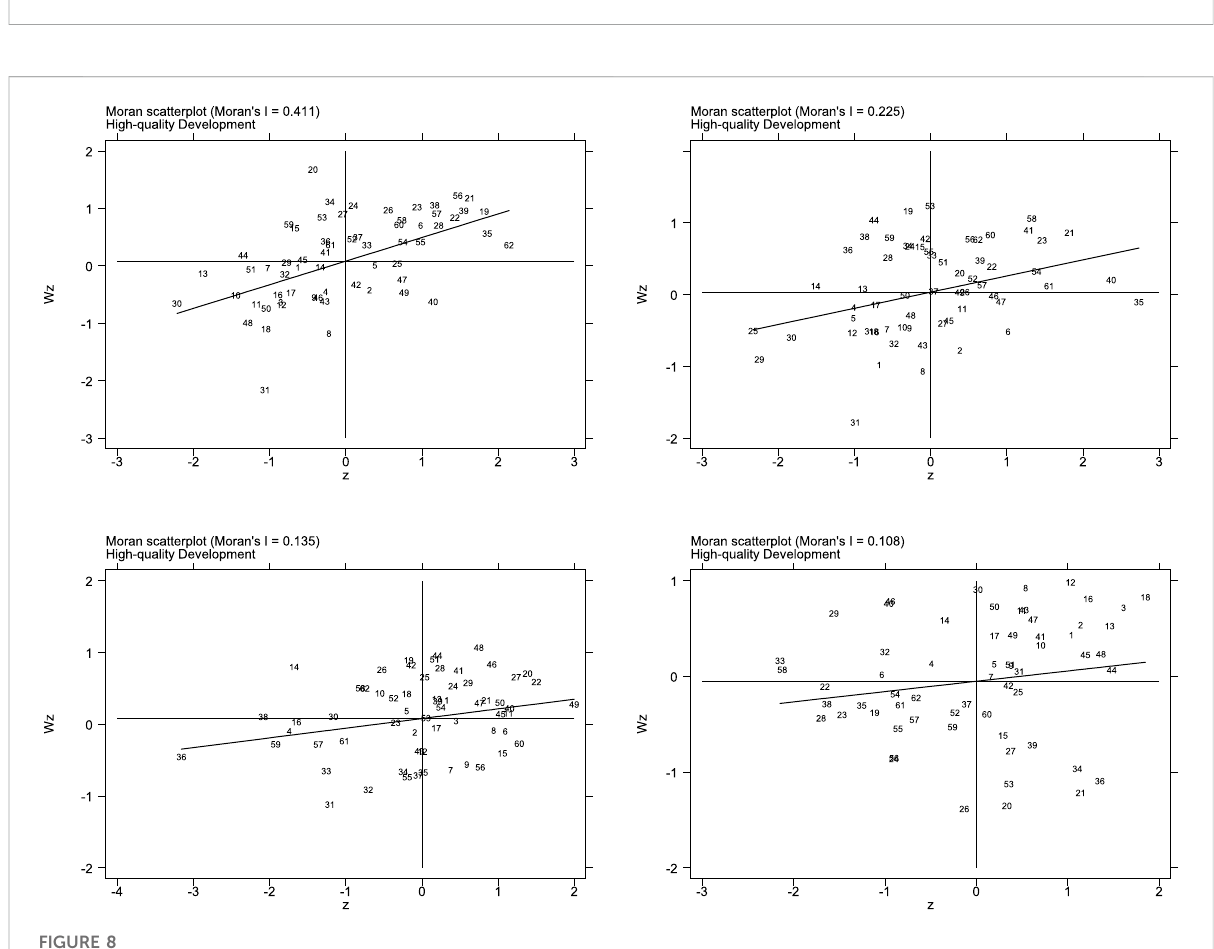
FIGURE 8 Local Moran diagrams of the level of high-quality urban development in 2008, 2012, 2016, and 2020. Note: the numbers 1 – 62 represent the 62 cities of the YRB,